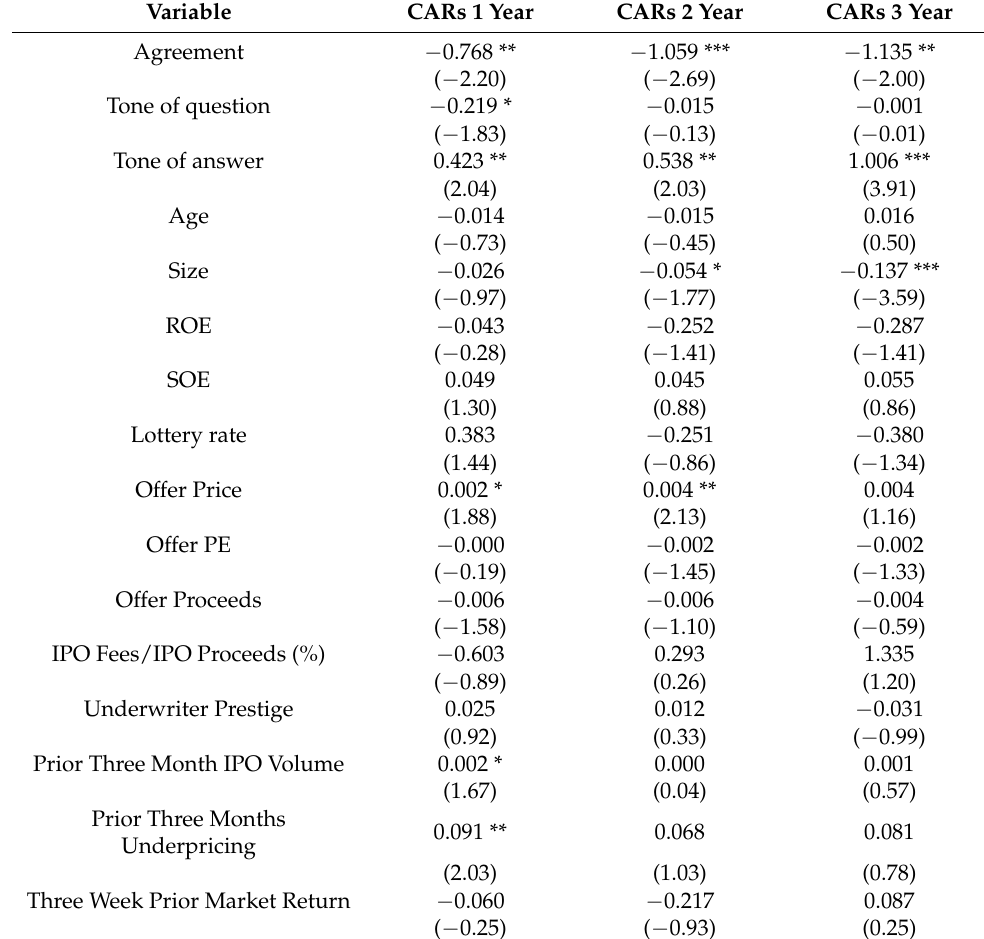
Table 5. Agreement and Subsequent Cumulative Abnormal